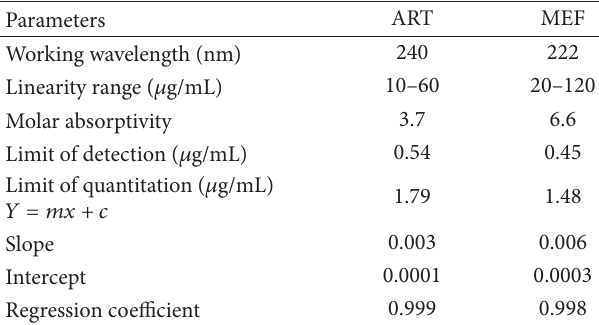
T 2: Optical characteristics and other